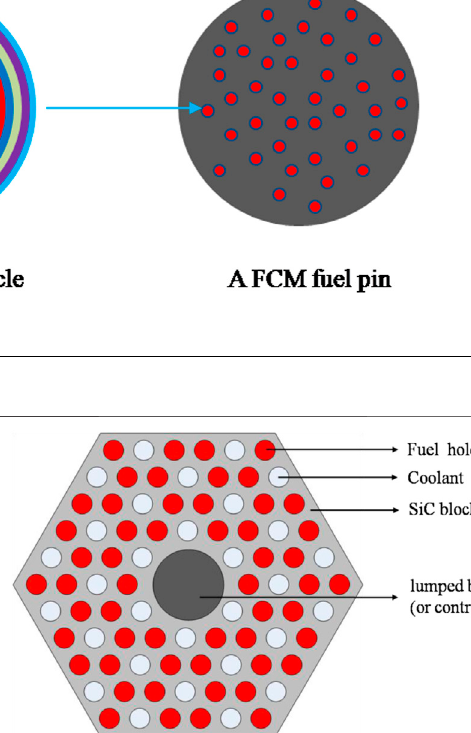
TABLE 2 | FCM fuel design parameters.